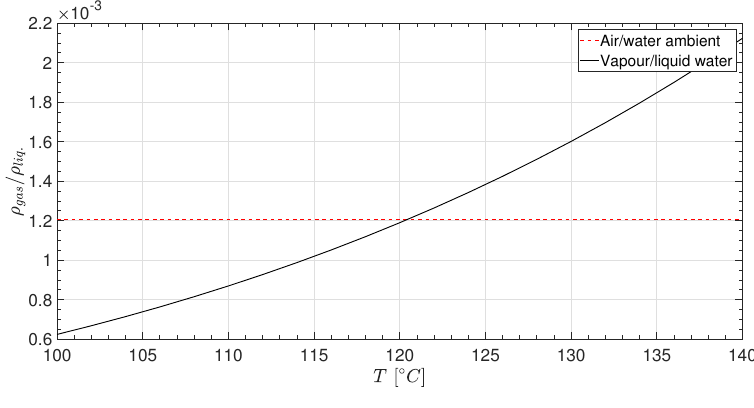
Figure 3. The density ratio between gas and liquid. Comparison between the test conditions with air/water and water